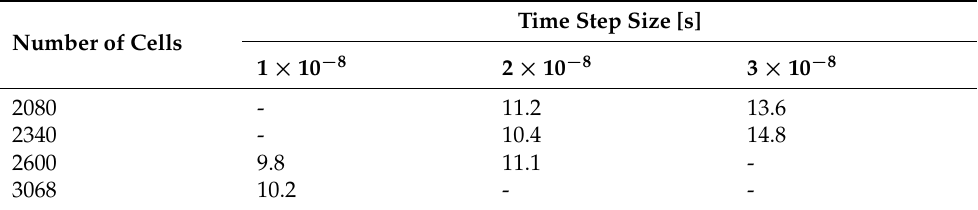
Table 1. Input data for the uncertainty estimation analysis. The values give the liquid spray penetra- tion length (in millimeters) at 0.2 ms (after start of injection) for various grids and time steps.